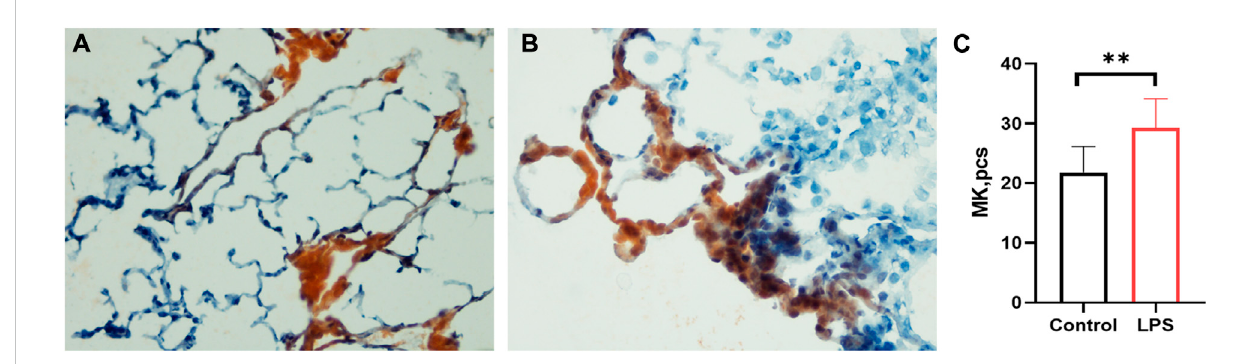
FIGURE 4 Lungmegakaryocytestainingandcounts. (A) .LungmegakaryocytestainingbyAchEinthecontrolgroup. (B) .LungmegakaryocytestainingbyAChE in the LPS-induced ARDS group. (C) . Lung megakaryocyte differences in the control group and LPS-induced ARDS group. (magni fi cation,